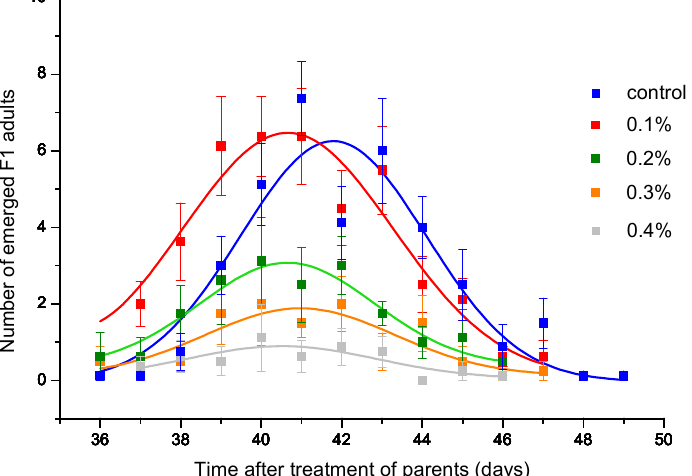
Figure 3. Daily emergence of Acanthoscelides obtectus F1 adults. Symbols represent means and standard errors for 8 replicates. Curve fit lines are from the equation in Table 4. Table 4. Parameters of non-linear regressions (means and confidence intervals in parentheses) of daily adult emergence in F1 generation depending on thyme oil concentration (C) according to the